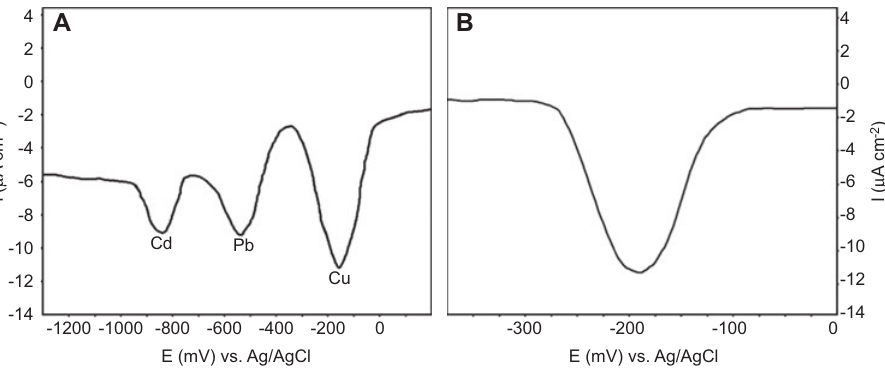
Figure 5 Square wave voltammograms of (A) 1 m m metal ions [Cd(II), Pb(II) and Cu(II)] mixture, (B) 1 m m Cu(II) ions at PolyChr/GC fi lm deposited in situ . Preconcentration potential -1300 mV, preconcentration time is 120 s. Supporting electrolyte BR buffer solution, pH 5. Measurement conditions: frequency 25 Hz, step potential 4 mV, amplitude 25 mV, equilibration time 15